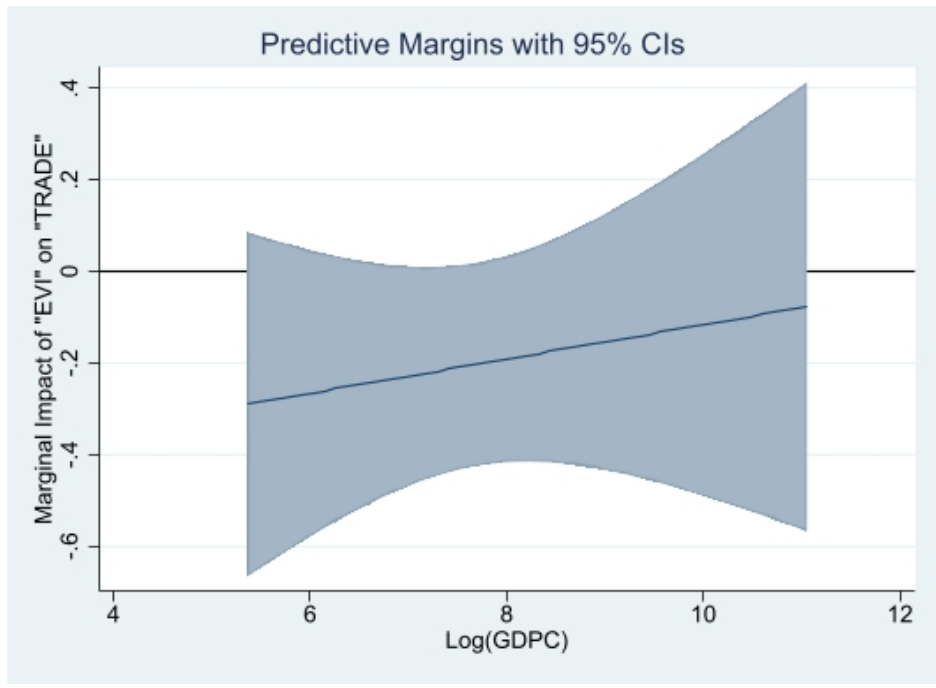
Figure 6. Marginal impact of “EVI” on “TRADE” for varying levels of the real per capita income. Source: Author.